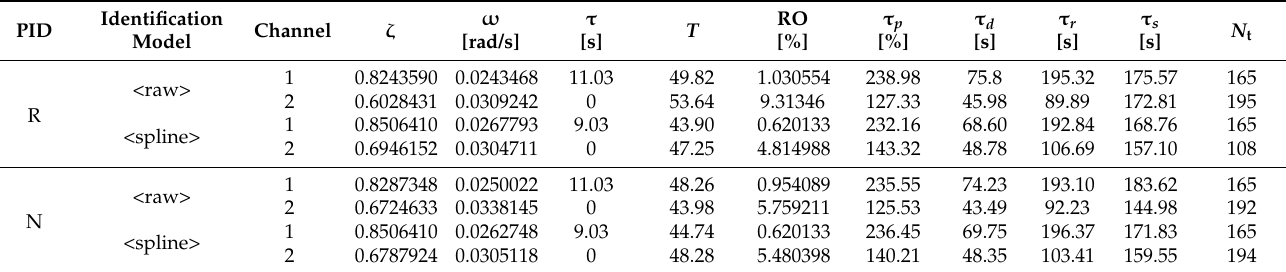
Table 6. Optimal PID controllers performance parameters related to second order step response.